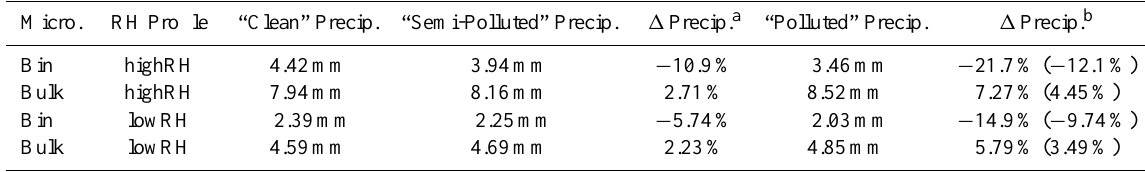
Table 2. Domain-averaged cumulative precipitation at the completion of the simulations performed, t = 6h. Micro.